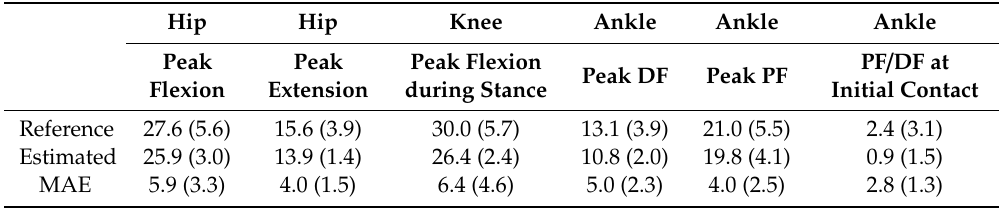
Table 5. Estimated and reference joint angles at discrete gait events in the inter-participant